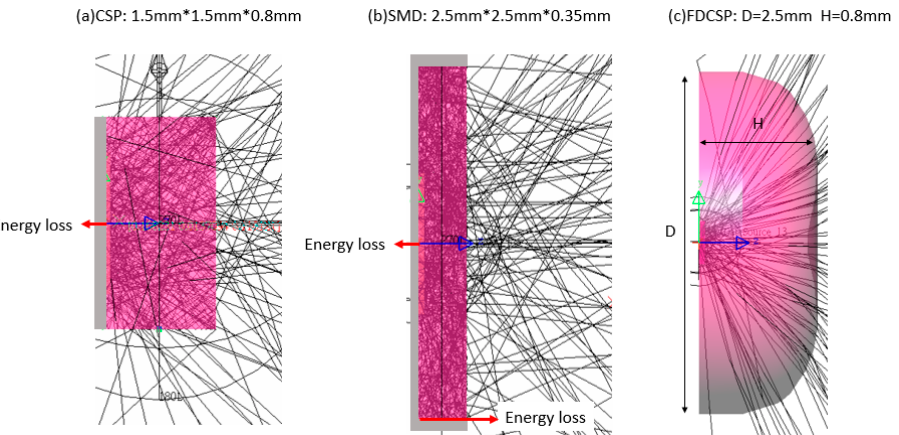
Figure 4. Light tracing profile of ( a ) CSP, ( b ) SMD, and ( c ) FDCSP.